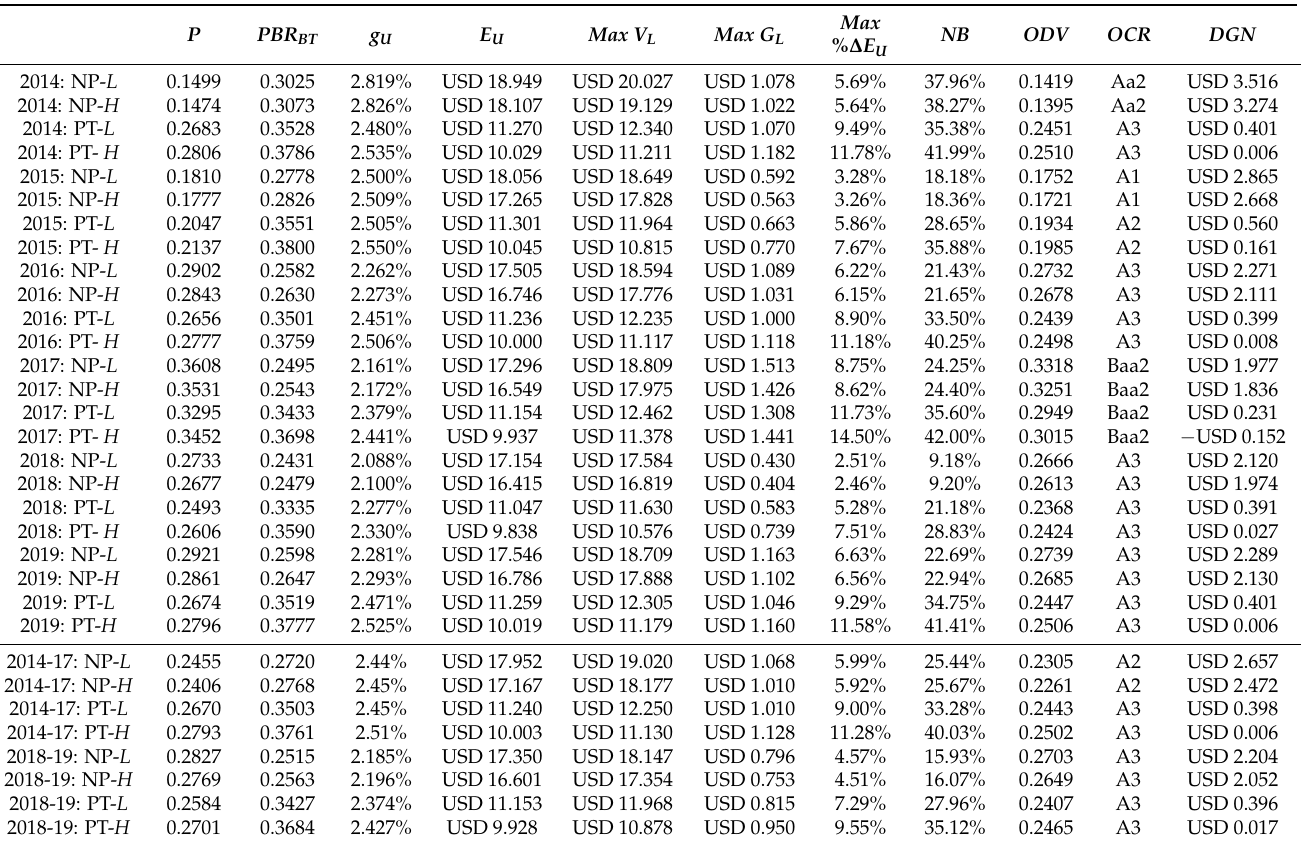
Table 5. Optimal Outcomes for NPs and